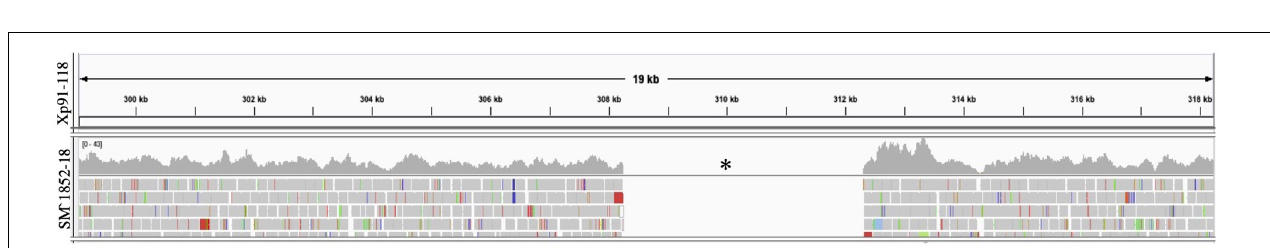
Frontiers in Microbiology |